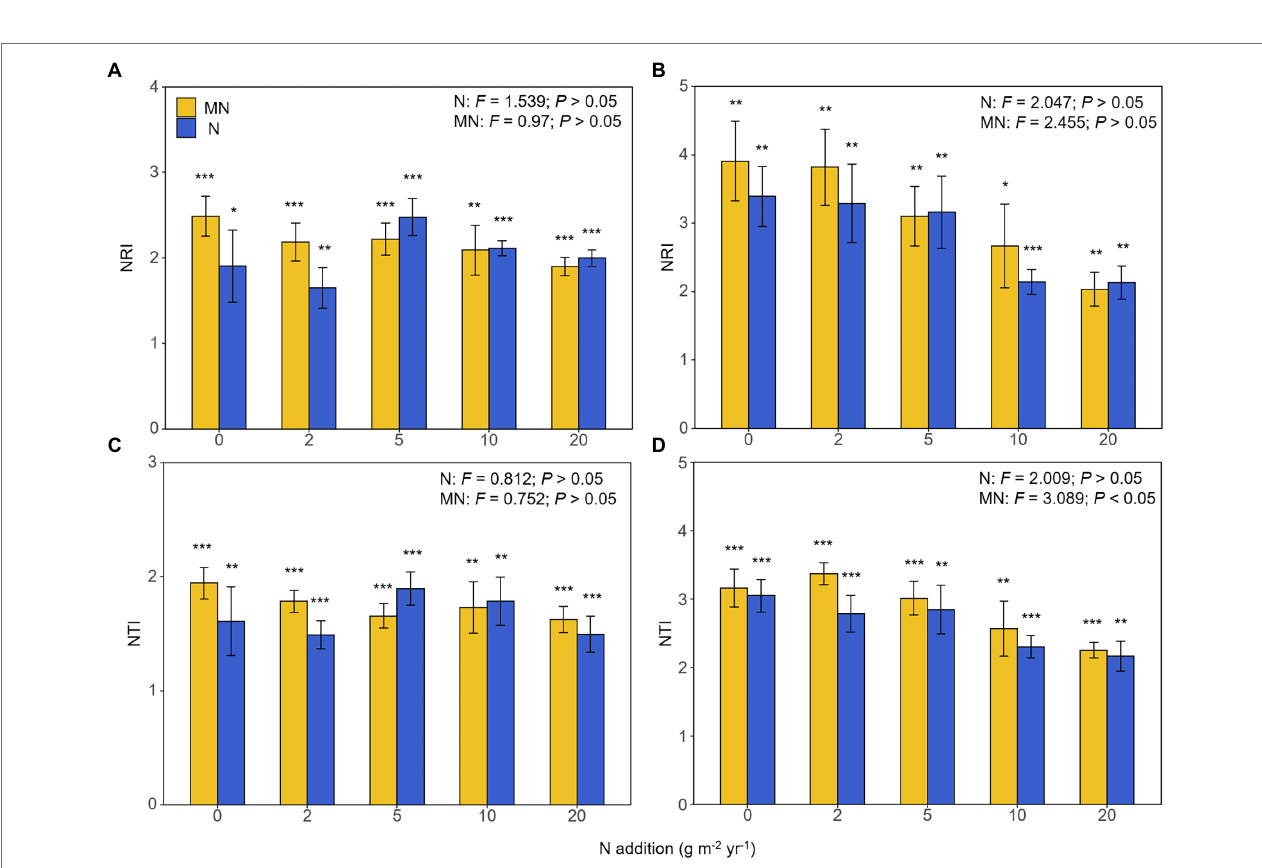
FIGURE 6 | The responses of the nearest relative index (NRI) of the arbuscular mycorrhizal fungal community in roots (A) and soil (B) to nitrogen addition and mowing treatments, and nearest taxa index (NTI) of the arbuscular mycorrhizal fungal community in roots (C) and soil (D) to nitrogen addition and mowing treatments. N, the effect of nitrogen addition; MN, the effect of mowing and nitrogen addition. * p < 0.05 of t- test, ** p < 0.01 of t -test, *** p <0.001 of t